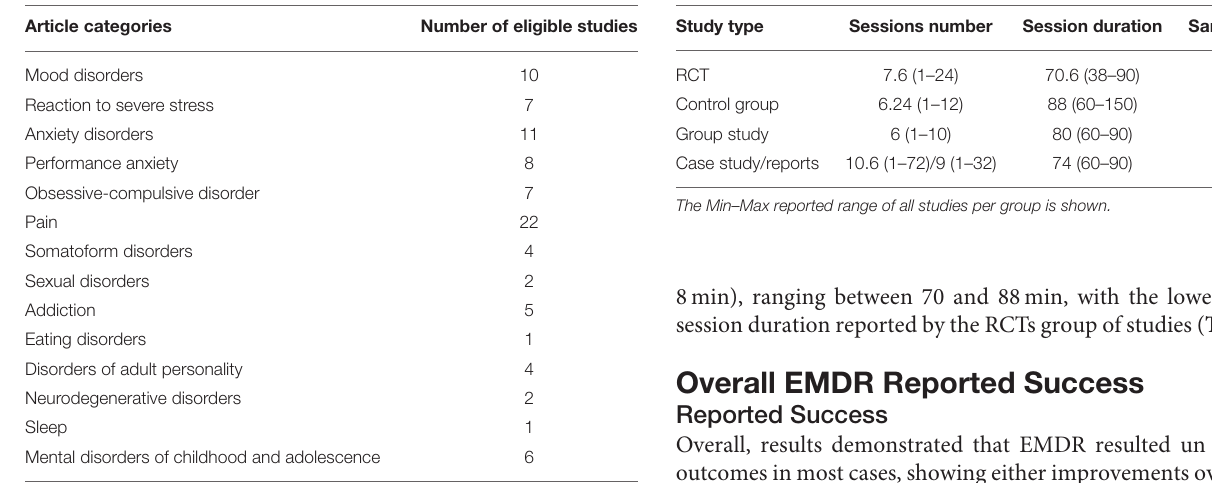
TABLE 2 | Summary of the article classification and the total of sample size of studies eligible for the systematic review.